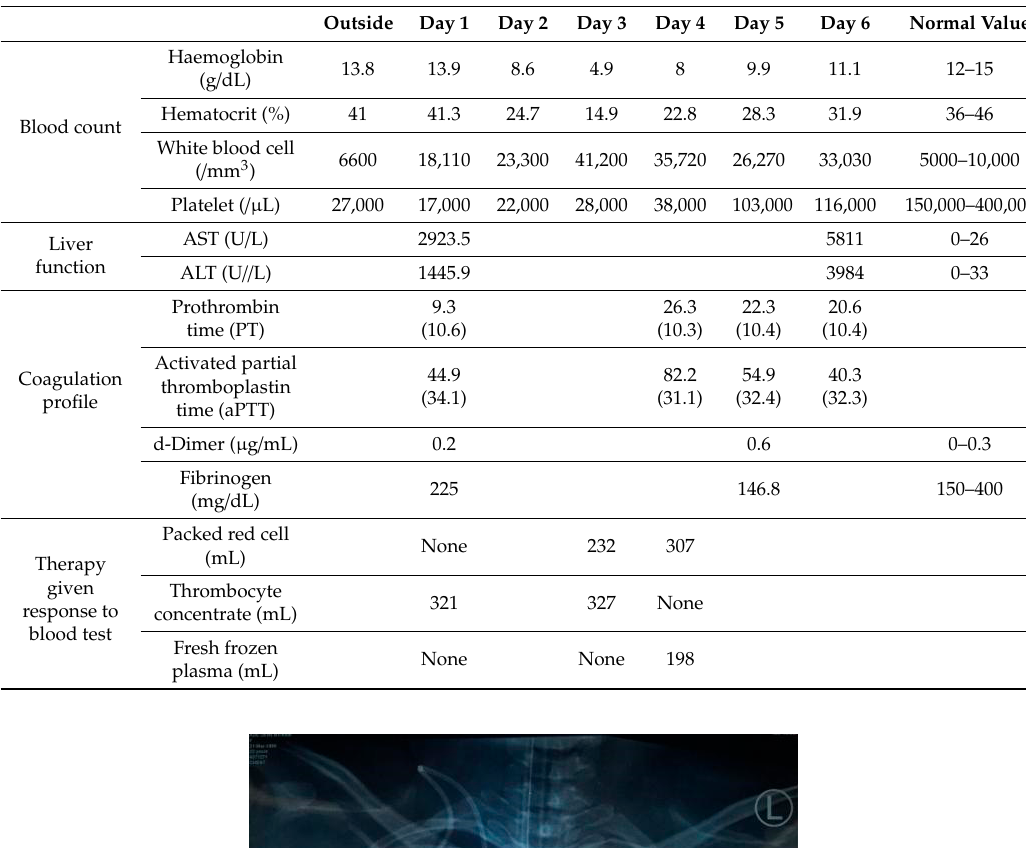
Table 1. Daily laboratory trend and therapy.